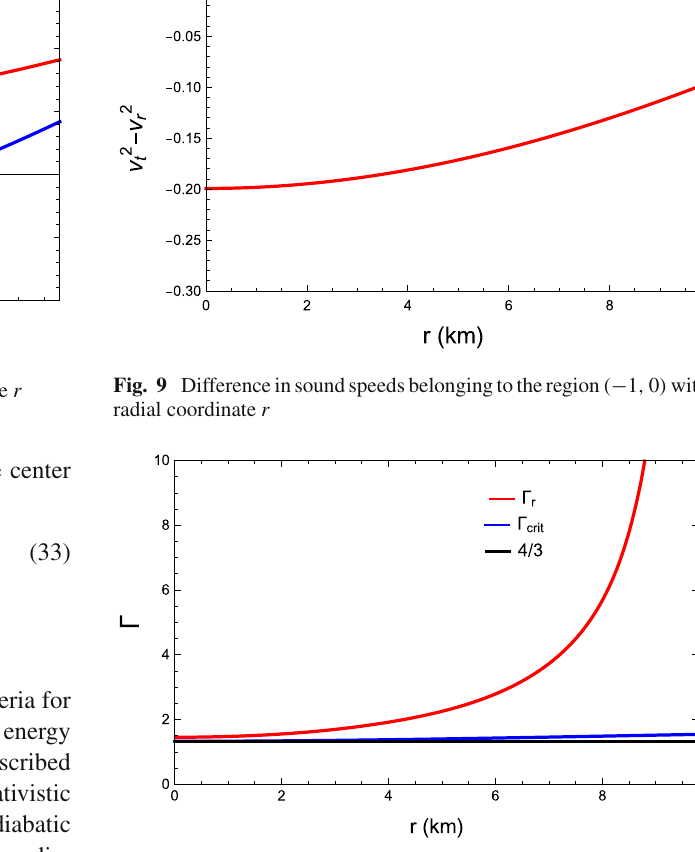
Fig. 10 Variation of adiabatic index with radial coordinate r for the pulsar